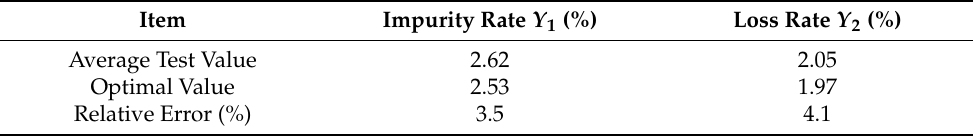
Table 5. Experimental values of the evaluation indices under optimal